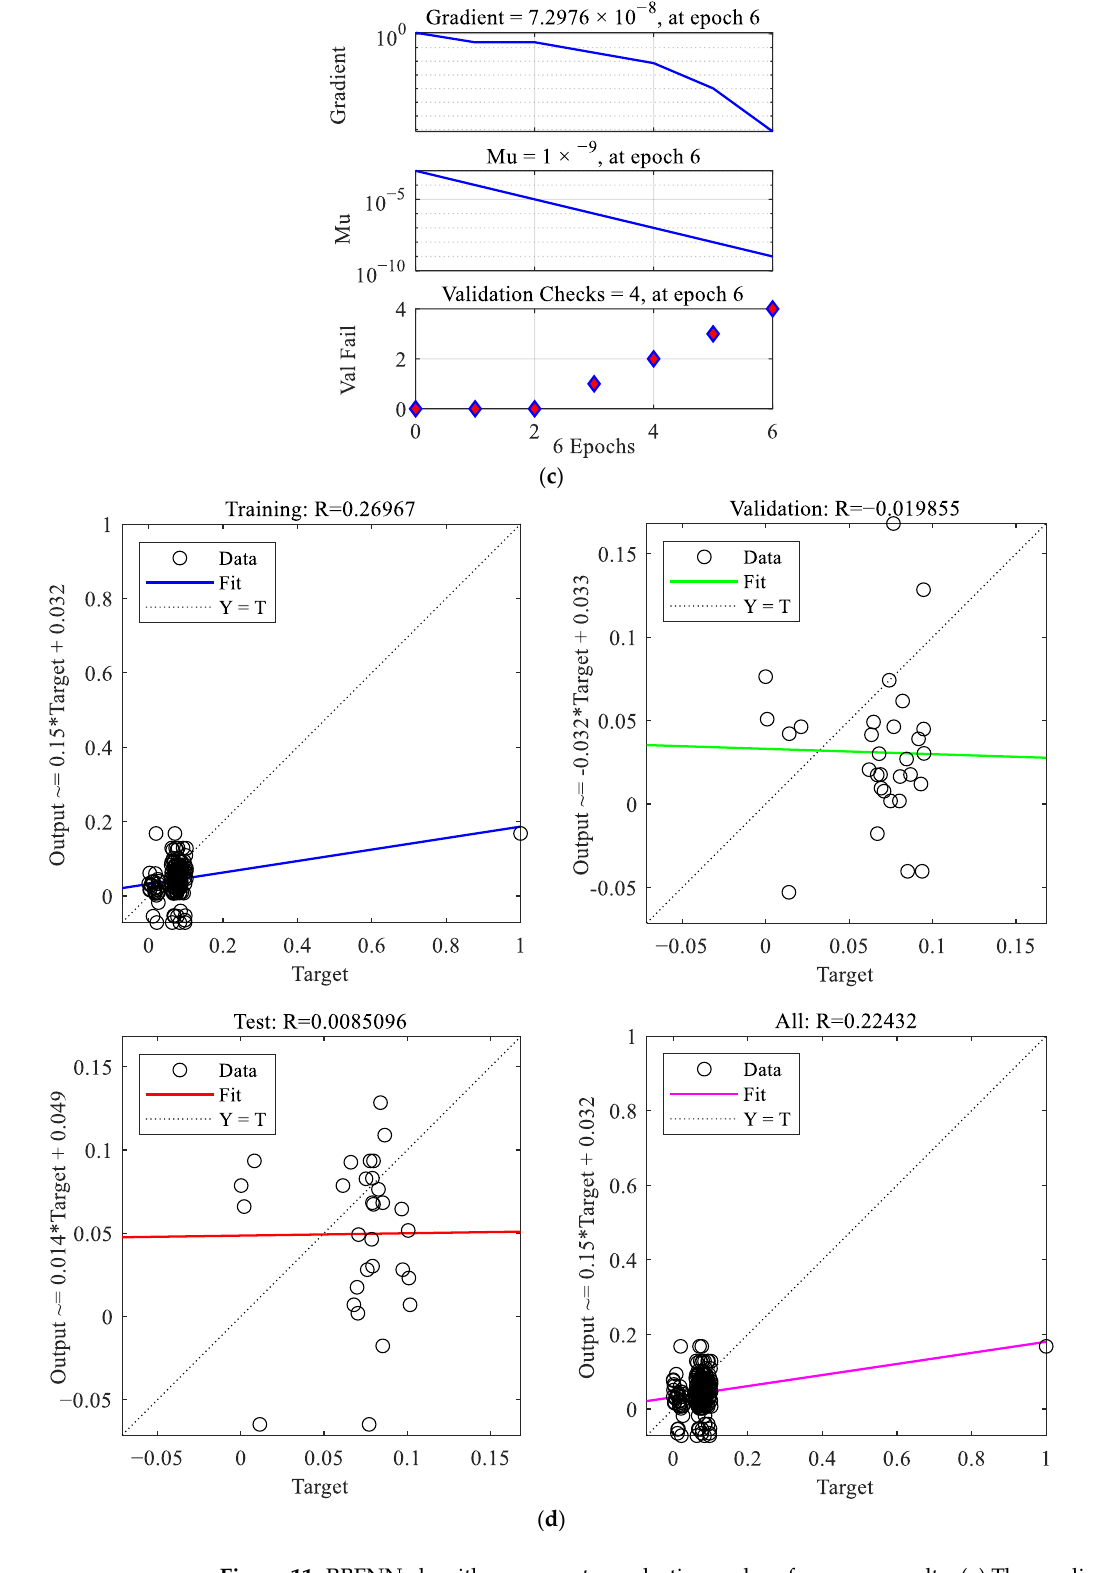
Figure 11. RBFNN algorithm parameters selection and performance results. ( a ) The prediction results of four different stations; ( b ) ARMA-RBFNN performance results; ( c ) ARMA-RBFNN training state results; ( d ) ARMA-RBFNN regression